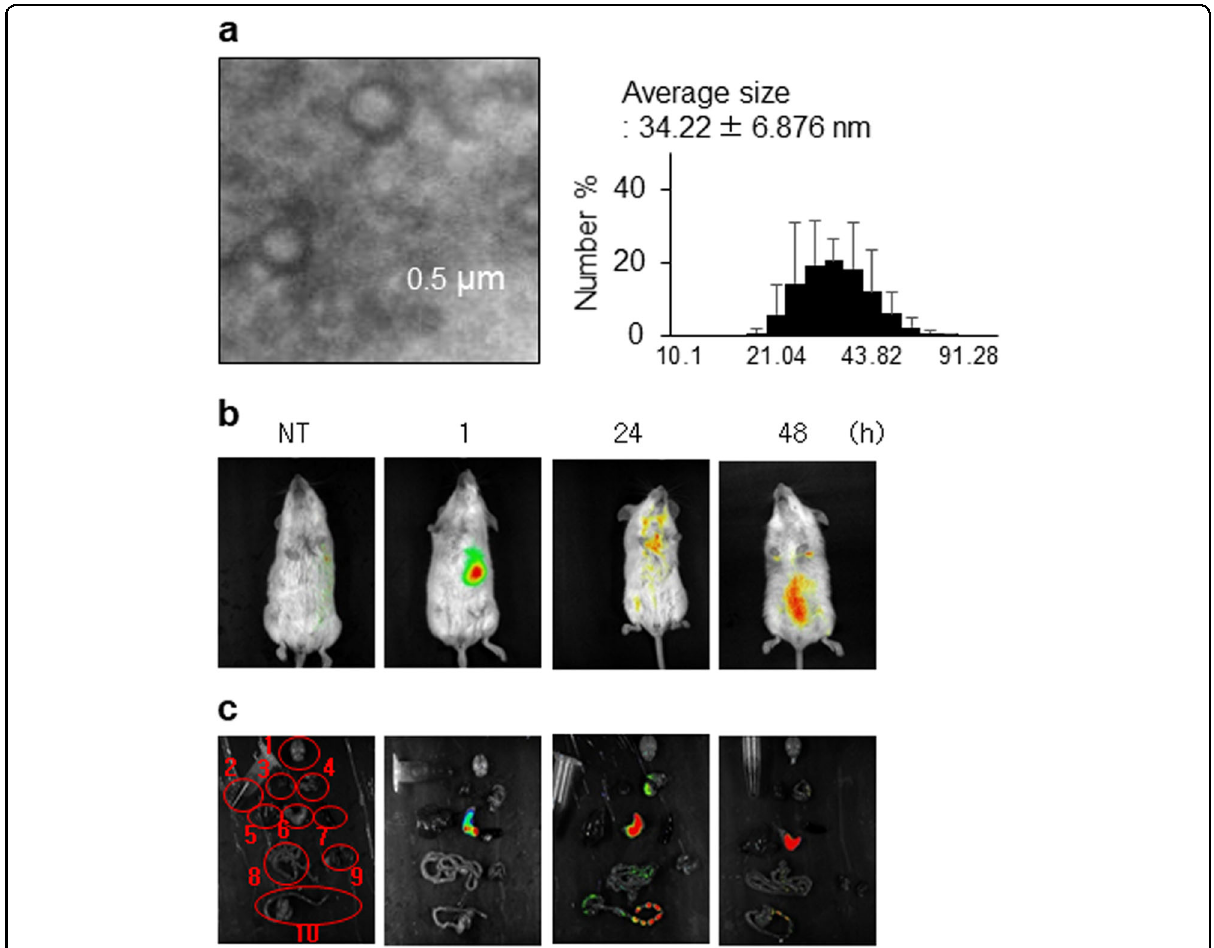
Fig. 2 Characterization of L. paracasei -derived EV (LpEVs) and targeting of LpEVs to the colon in the mouse model. a TEM images (×80,000) of EVs extracted from L. paracasei -grown media on day 5. The diameters (nm) of LpEVs measured by nanoparticle tracking analysis (NTA) on day 5 ( b , c ) in vivo fl uorescence assay. LpEVs were labeled with Cy7-NHS, and 10 µg of Cy7-labeled LpEVs was administered by gavage to the mice. After administration, the fl uorescent signal of the whole body or dissected organs was detected depending on the time. 1. brain, 2. blood, 3. heart, 4. lung, 5. liver, 6. stomach, 7. spleen, 8. small intestine, 9. kidney, 10. large